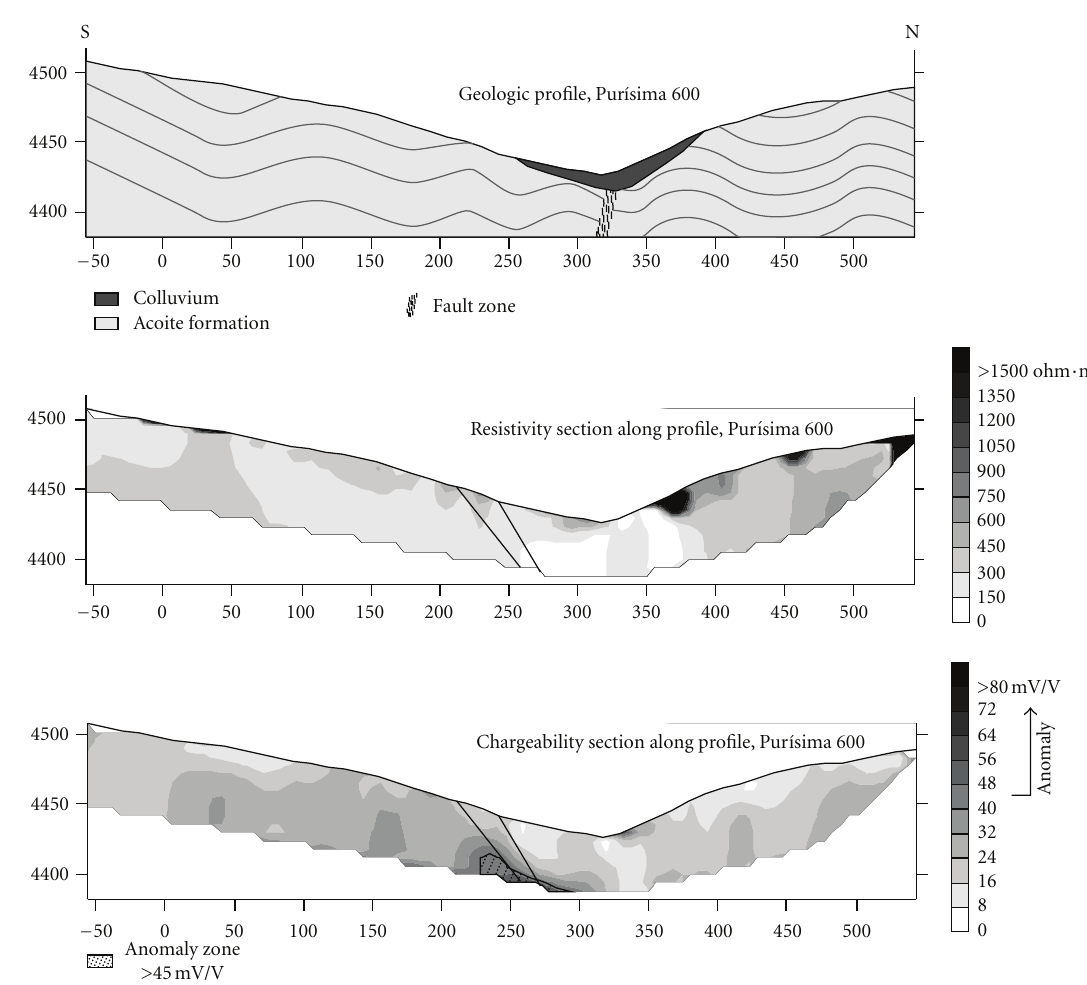
Figure 7: Geological, resistivity, and chargeability profile no. 600 for Pur´ısima section. The veins studied are spatially associated with a low-resistivity area, coincident with the valley’s main axis. An anomalous chargeability area coincides with the veins at 50m depths.